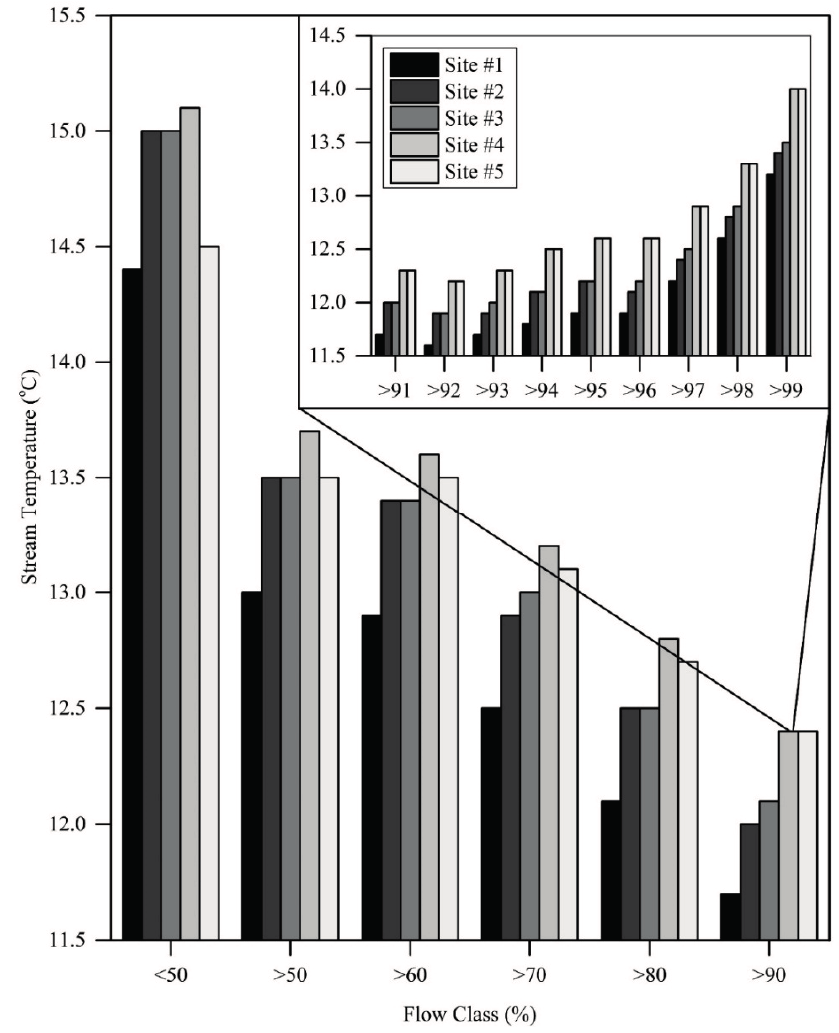
Figure 3. Mean stream water temperatures above and below median values for each gauging site (WY 2011 to 2012) in Hinkson Creek Watershed, USA. The nested plot expands the >90% flow class for a total of 15 flow